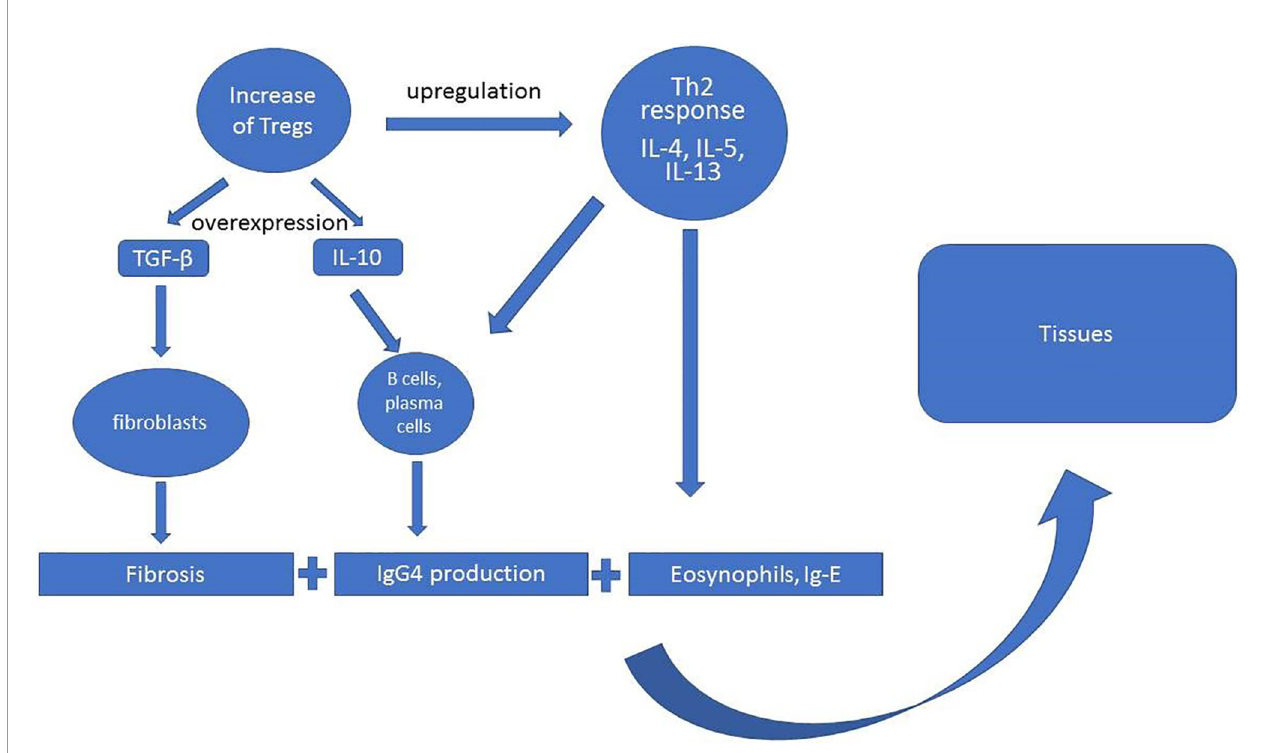
FIGURE 2 | Outline of IgG4-related disease pathogenesis (55, 58,